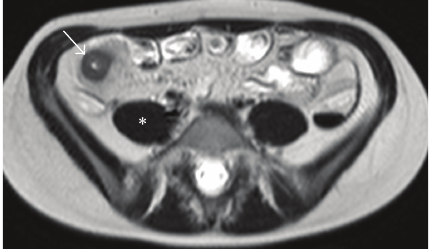
Figure 2: MRE, T2W axial image. Edema was diagnosed when the involved loops (arrow) showed higher signal intensity compared with psoas muscle ( ∗ ) in T2W